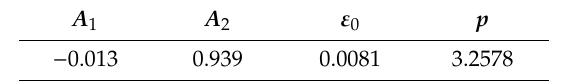
Table 8. Identification results of parameters of mean of the damage variable µ d ( ε ) .